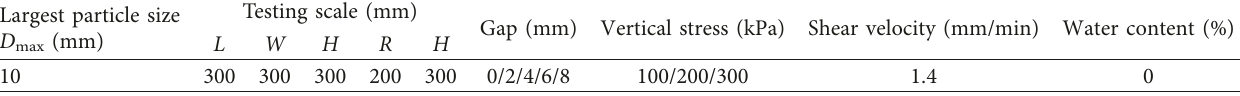
Table 1: The related parameters of the direct shear test of S-RM considering the gap effect. Testing scale Largest particle size D max (mm)